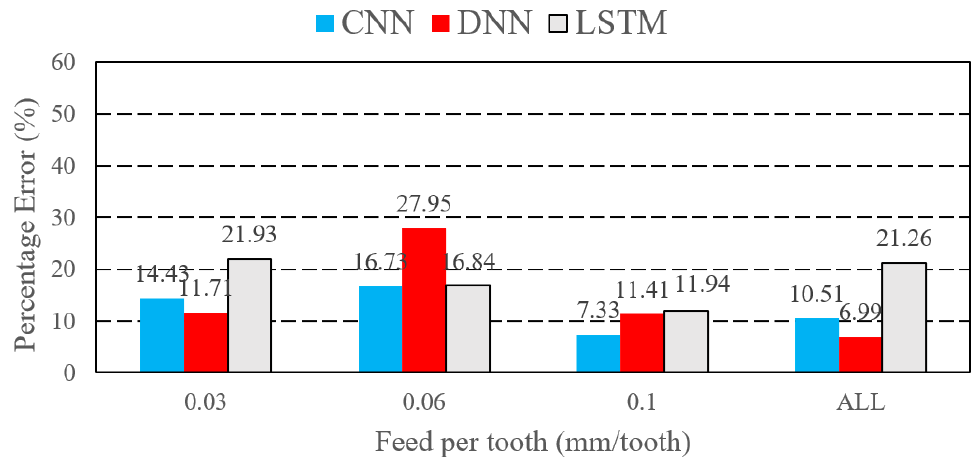
Figure 22. Percentage error of dimensional accuracy prediction.